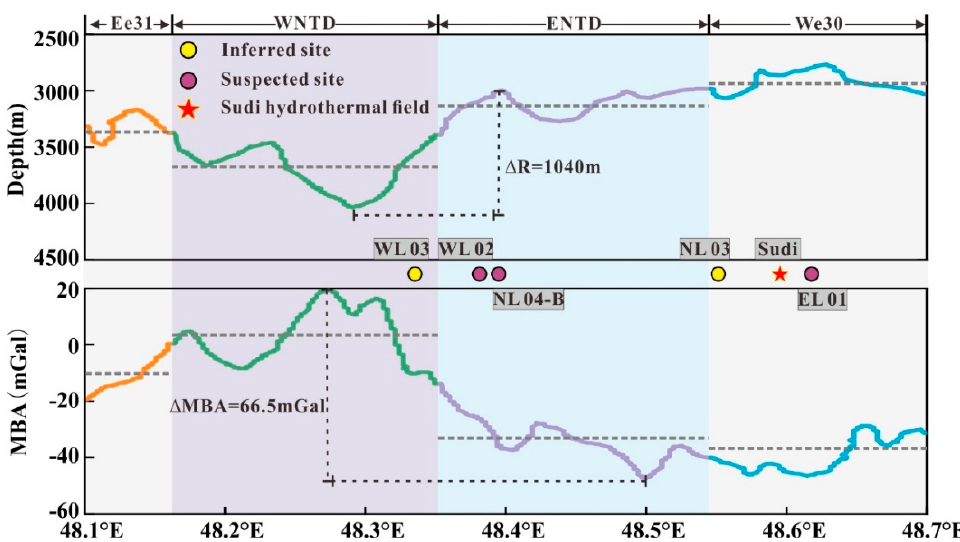
Figure 2. Along-axis topography and MBA of the study area (data from [36]). The profile is separated into 4 sections along the strike of the ridge axis (i.e., along the red lines and the white dotted line): Ee31 marks the eastern end of segment 31, WNTD marks the western part of the large NTD, ENTD is the eastern part of the large NTD and We30 denotes the western end of segment 30. The projection of hydrothermal anomaly sites perpendicular to the ridge axis is shown between 2 panels. Gray dotted lines represent the average value of each section. For clarification and differentiation of suspected sites and inferred sites, see Section 4.2.